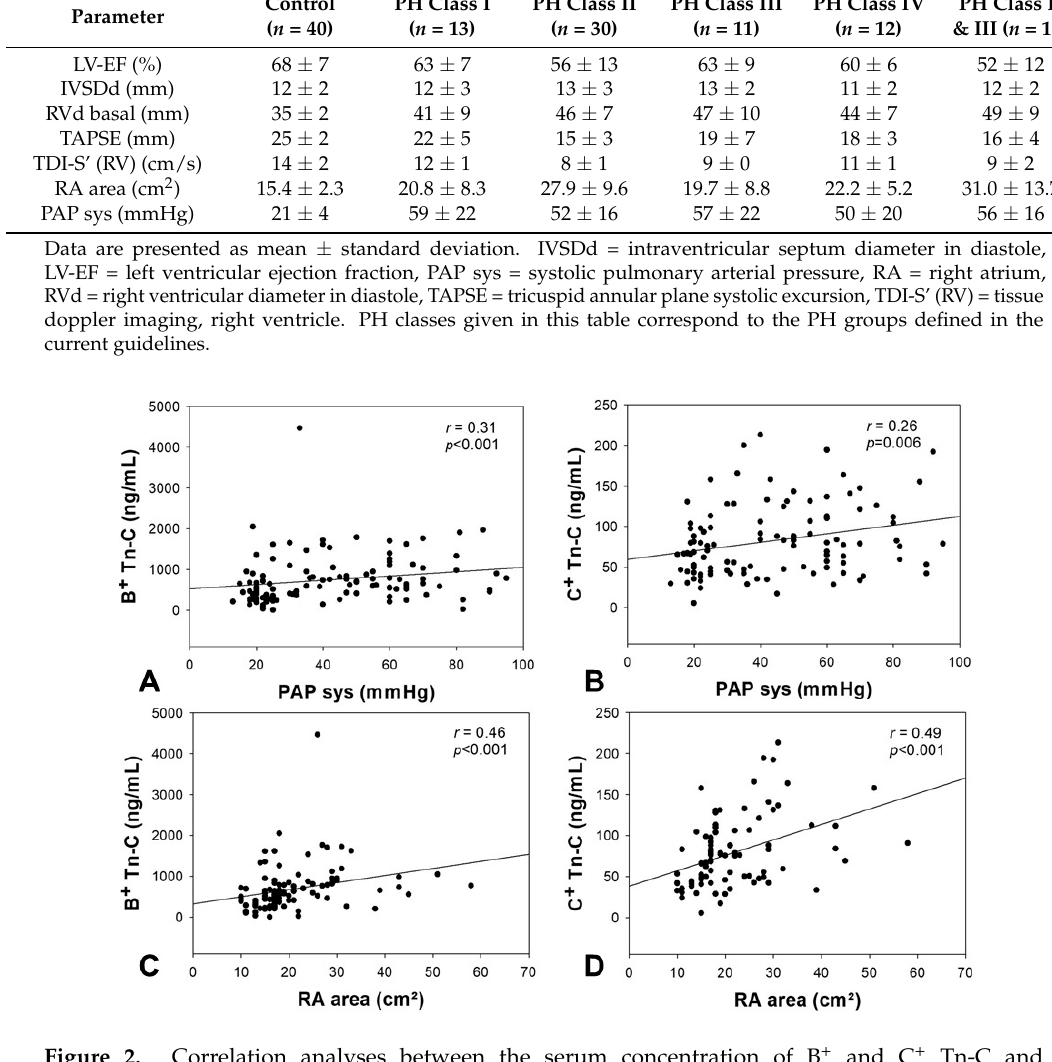
Figure 2. Correlation analyses between the serum concentration of B + and C + Tn-C and echocardiographic parameters. The correlation analysis graphs demonstrate significant correlations between B + and C + Tn-C and the systolic pulmonary artery pressure ( A , B ), as well as the area of the right atrium ( C , D ). PAP sys = systolic pulmonary arterial pressure, RA = right atrium, Tn-C = tenascin C, p -value = level of significance, r-value = correlation coefficient.